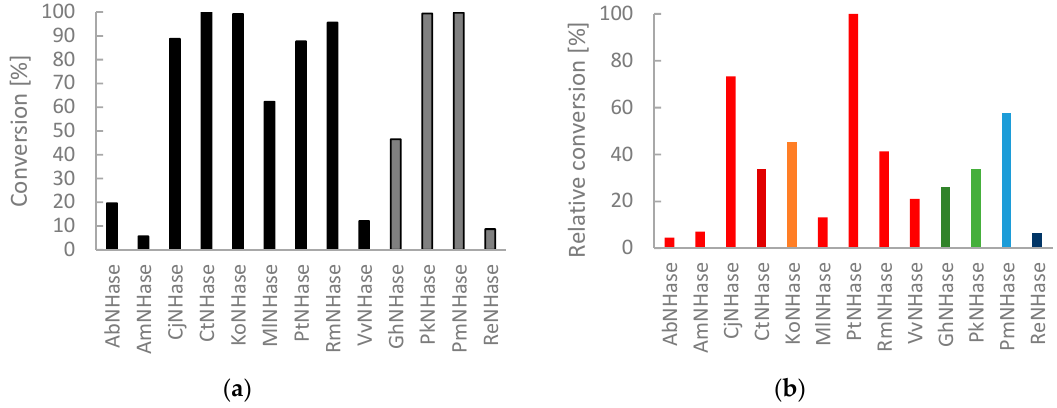
Figure 5. ( a ) Amide formation from 5 mM 2a with NHase CFEs (1:200 dilution) in 100 mM KH 2 PO 4 buffer at pH 7.2 and 25 °C. Reaction time 5 min. Na NHase was not included. Calculation was based on area normalization. All omitted NHases were inactive for 2a hydration under these conditions. Black: Co and Grey Fe-dependent NHases; ( b ) Relative activities of NHases. Red tones: Co- and Green/Blue Fe-dependent NHases.